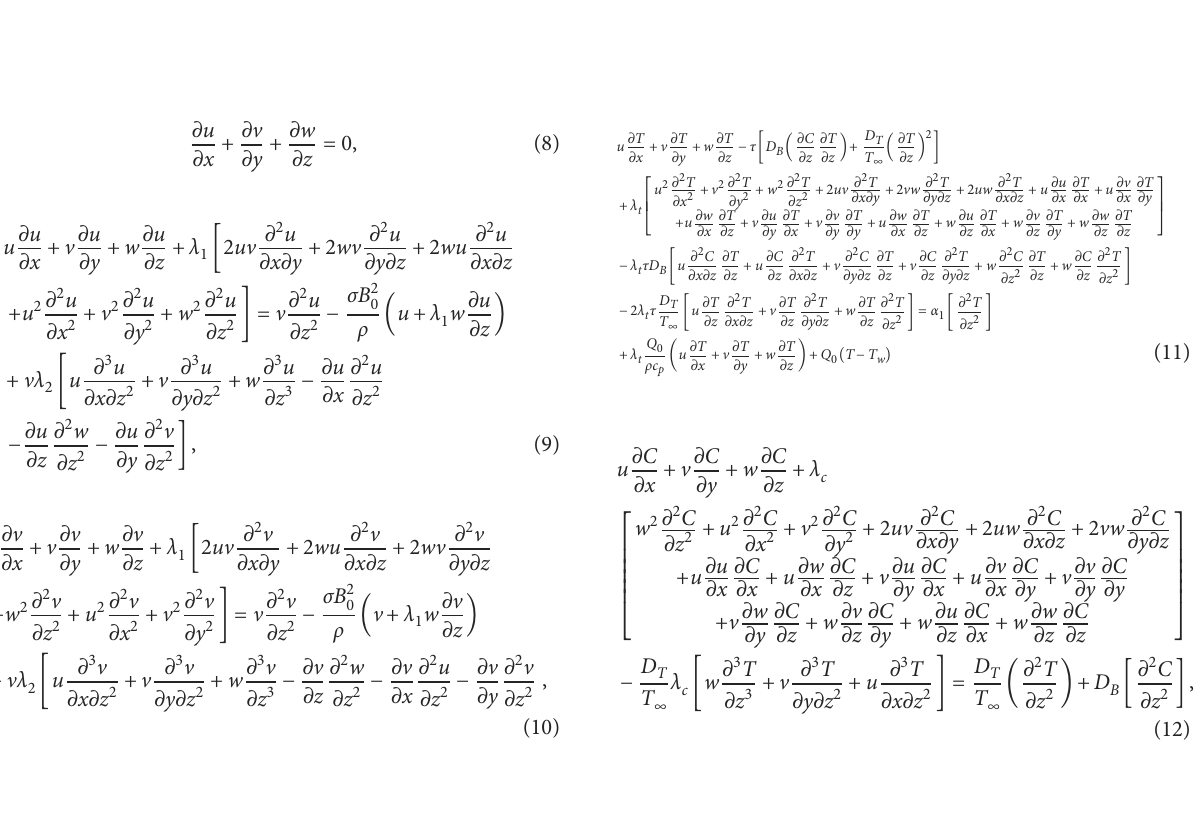
FIGURE 2 (A–D) Impact of R on f ′ , g ′ , θ , and ϕ